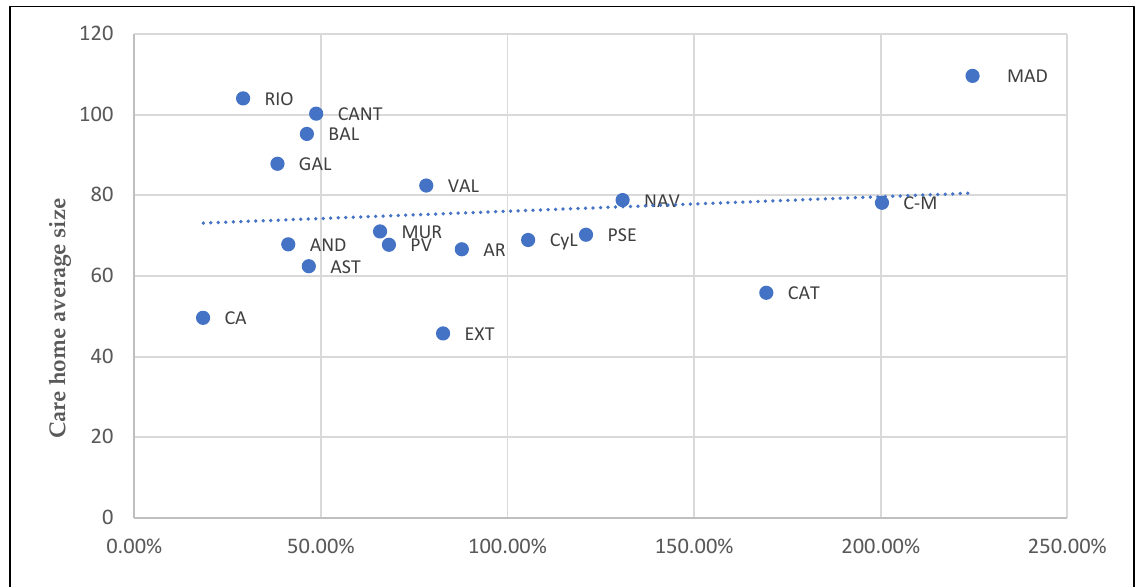
Figure 4. Excess deaths among care home publicly funded bed beneficiaries and average number of beds in care homes in each AC. Source: Authors’ work using data from IMSERSO [24,27].